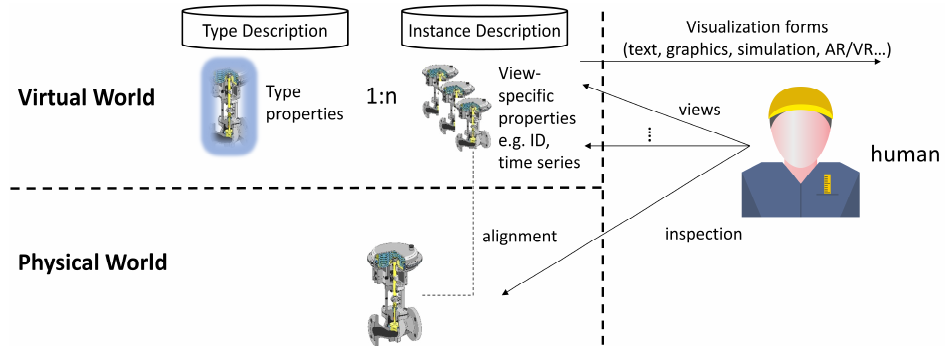
Figure 1. Conceptual view on digital twins.